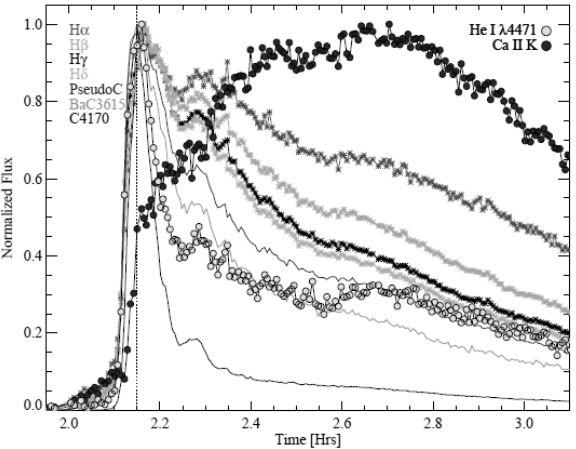
Figure 7. Radiation flux curves for YZ CMi. Figure from (Kowalski et al.,